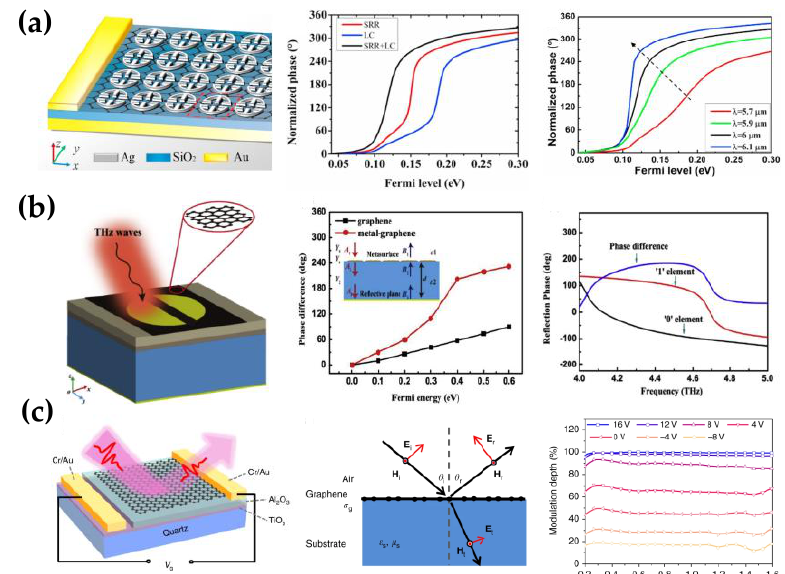
Figure 6. The reflective tunable graphene terahertz phase modulator. ( a ) Graphene − metal hybrid modulator was composed of the silver split ring and nanorod with monolayer graphene as active material, the phase tunability of SRR and LC is smaller than that of the coupling structure; the phase modulation range and smoothness under four incident wavelengths, the maximum shift of nearly 360° can be achieved at 6.1 μm ; (Reprinted with permission from ref. [81] Copyright 2021, Elsevier) ( b ) Reflection unit consisted of a graphene sheet and a gold disk separated in the middle, comparison of phase difference for the bare graphene and the metal − graphene metasurface at 4.5 THz; the reflection phase distribution of ‘ 0 ’ ( E F = 0.05 eV) and ‘ 1 ’ ( E F = 0.4 eV) elements in coding metasurface, the phase difference was approximately 180° at frequency from 4 THz to 5 THz; (Reprinted with permission from ref. [78] Copyright 2021, Elsevier) ( c ) Tunable Brewster reflection phase modulator based on graphene/quartz surface with broad bandwidth and high modulation speed; diagram of the incident light from air to graphene/silica substrate, which was the operation principle for the Brewster modulator; the broadband phase modulation can be achieved under different gate voltages in the frequency range of 0.2 − 1.6 THz. (Reprinted with permission from ref. [79]. Copyright 2018, Nature Publishing Group)